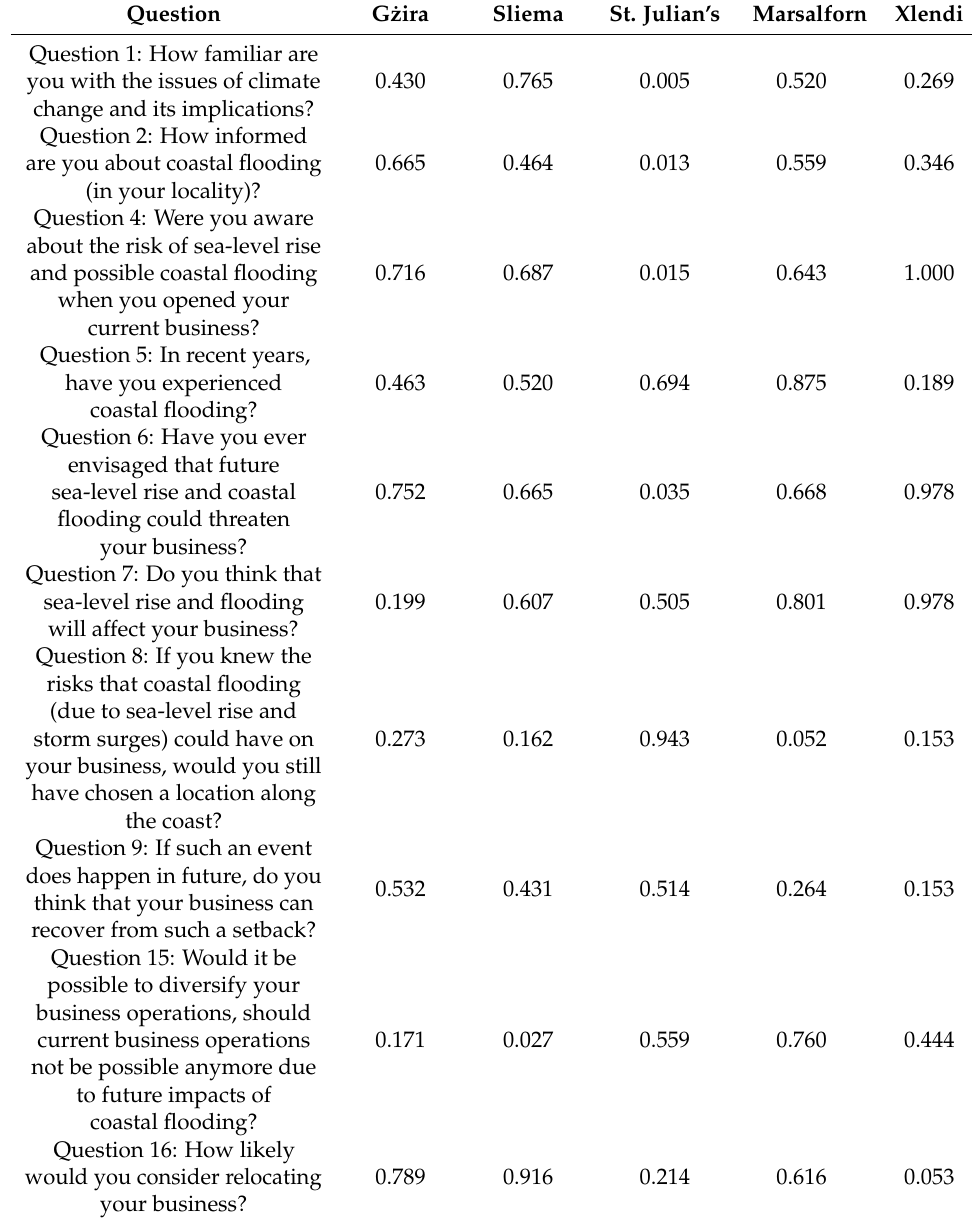
Table 5. Results from Kruskal Wallis H-Tests for selected businesses owners’